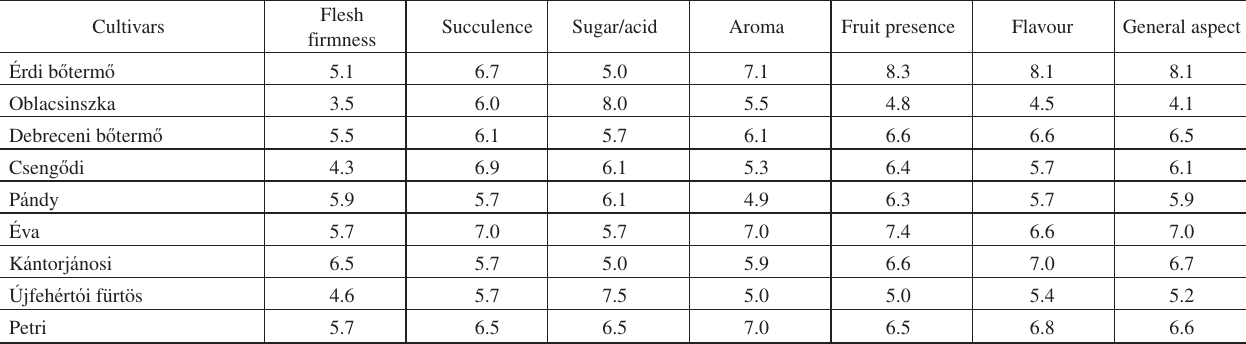
Table 3. Panel test of sour cherry cultivars average of the years